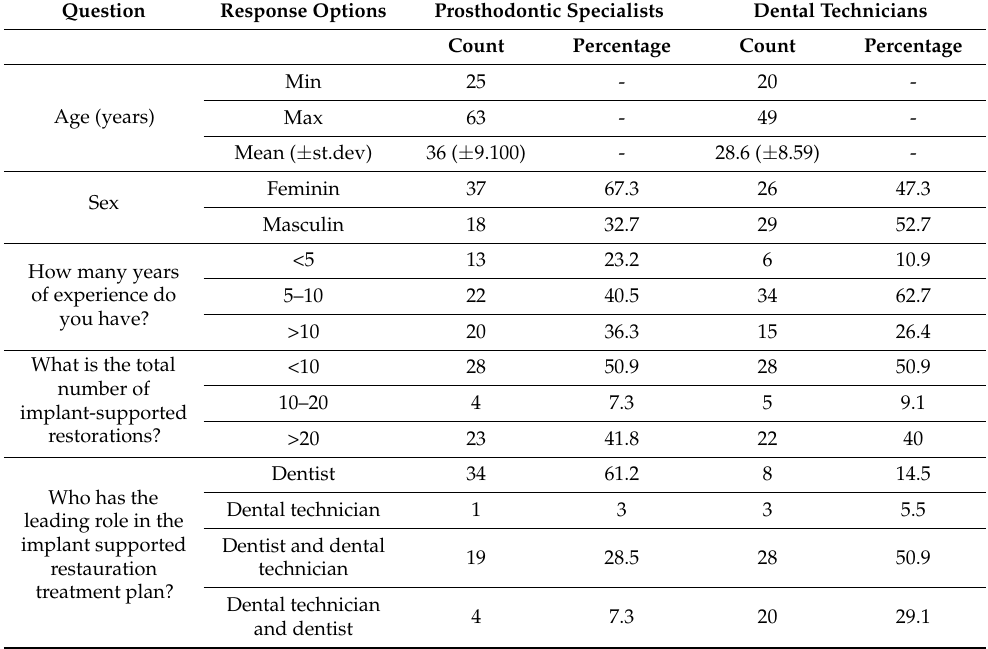
Table 1. Respondents’demographic data.